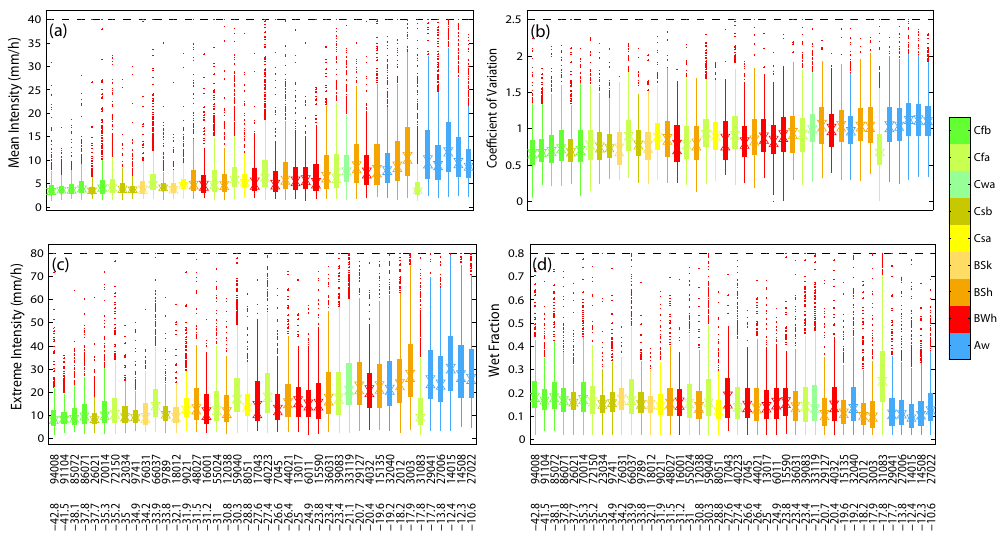
Fig. 9. Box plots showing variation in daily mean wet period intensity, daily wet period intensity coefficient of variation, extreme intensity I HI , and wet fraction. Boxes are arranged from highest (most southerly) to lowest latitude and are labelled with station number and latitude. Colours show K¨oppen climate classification of the stations (see Fig. 1). All intensity statistics use 6-min data. Boxes show the inter-quartile range, whiskers extend 1.5 times the inter-quartile range and notches show confidence limits on the median.